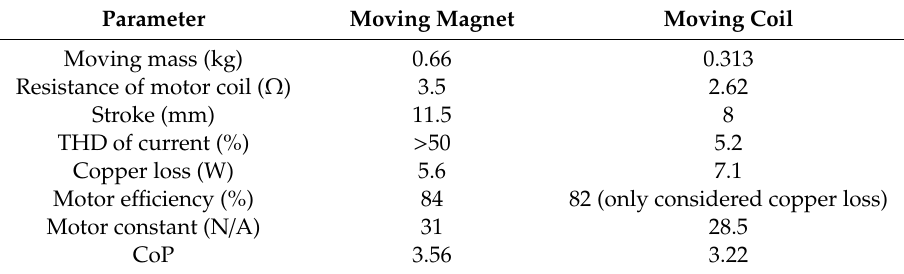
Parameter Moving Magnet Moving Coil Moving mass (kg)